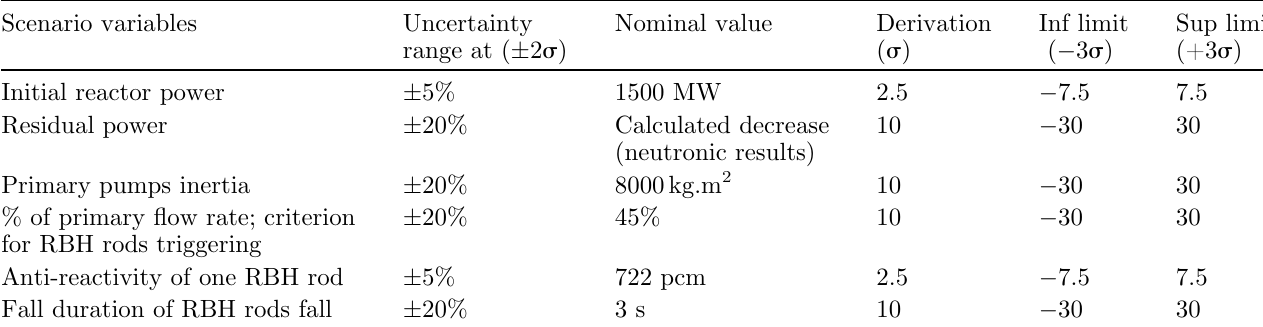
Table 5. Main scenario uncertainties (cid:1) truncated normal law at ±3 s ⋅ Scenario